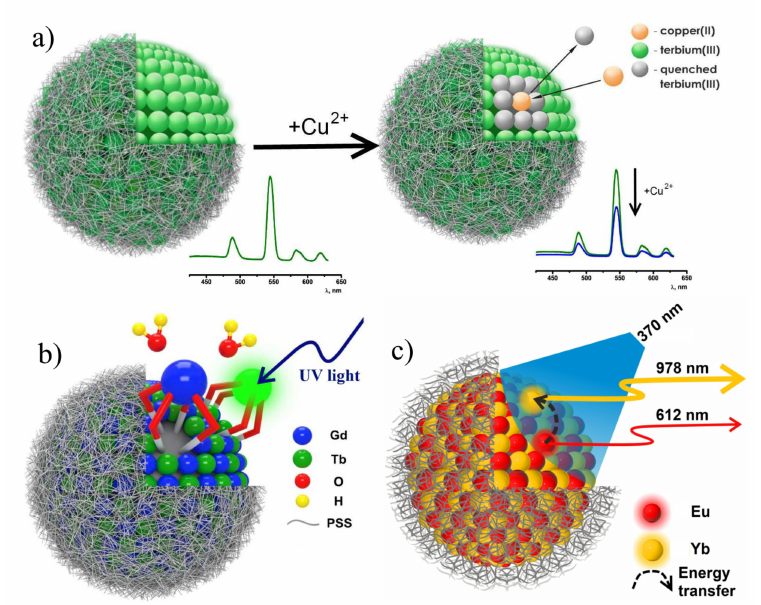
Figure 13. ( a ) Illustrative demonstration of Tb 3+ -centered luminescence quenching by copper(II) ions. ( b ) Schematic structure of heterometallic Tb 3+ and Gd 3+ PSS-coated nanoparticles. ( c ) Representation of Eu → Yb energy transfer in PSS-[Ln (TTA) 3 PhO] colloids. Reproduced from Refs. [61,106,108] with permission from the Springer Nature and the